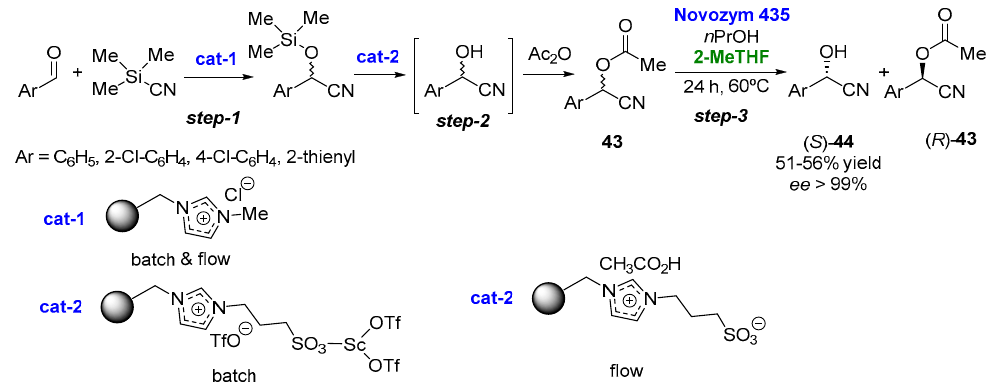
Figure 22. Chemoenzymatic cascade leading to pure chiral